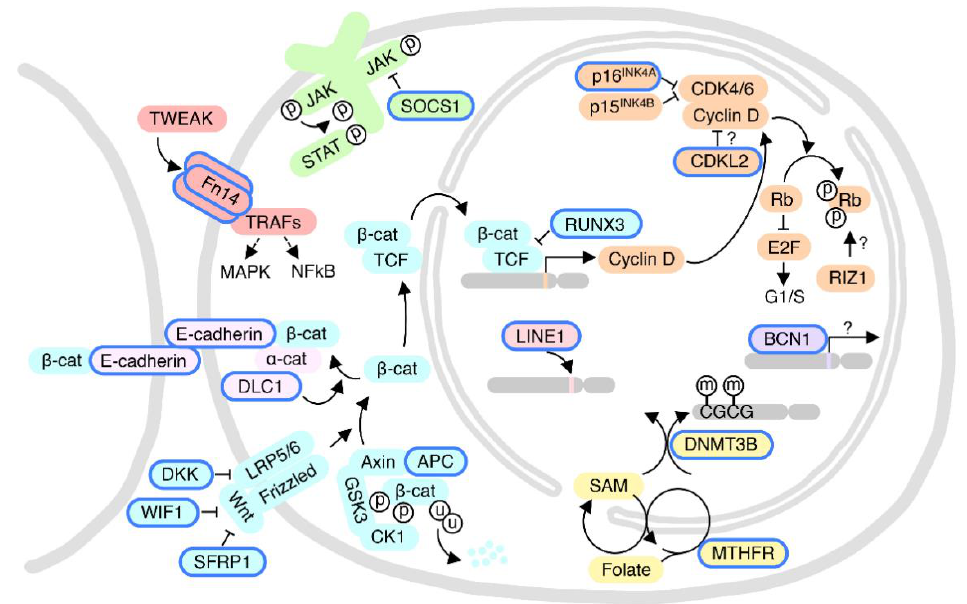
Figure 4. Cellular pathways implicated in sex/gender-related DNA methylation changes in HCC. Color schemes represent different pathways. Proteins regulated by sex/gender-related DNA methylation, or with gene variants having sex/gender-related differences, are highlighted by blue margins. Circles labeled with p, u, and m represent phosphorylation, ubiquitination, and methylation, respectively. Pointed and blunted arrows represent activation and inhibitory activities, respectively. Question marks indicate unclear underlying mechanisms. See text for protein abbrevia- tions.